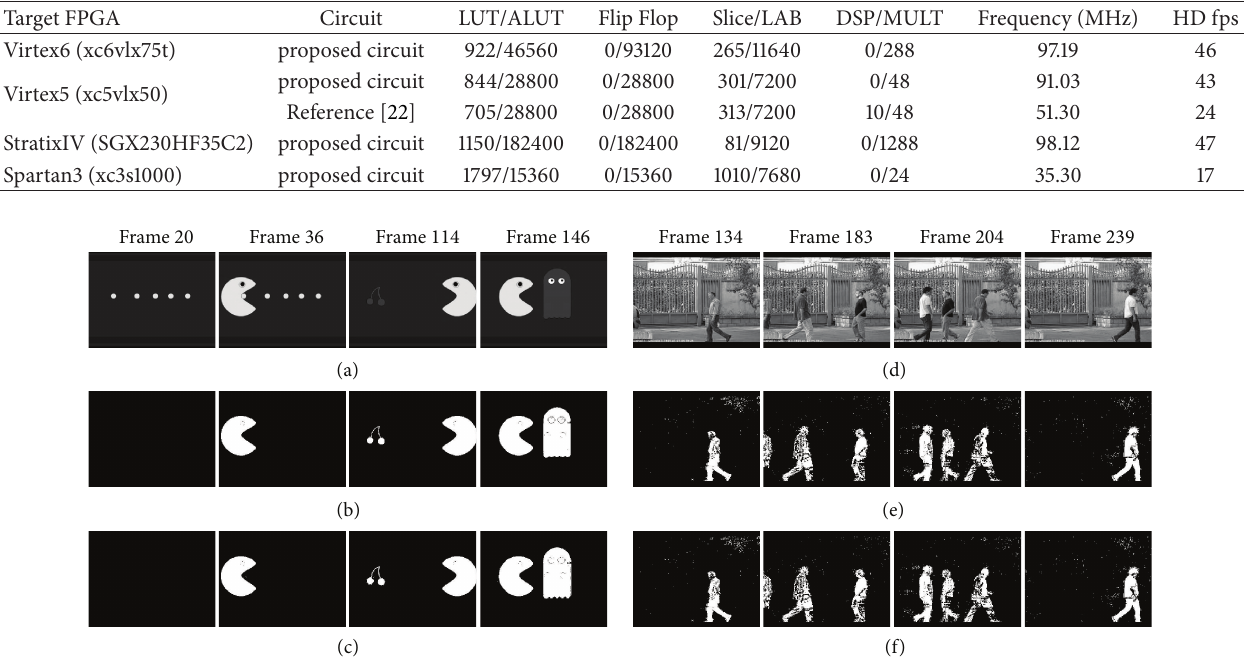
Figure 4: Comparison between the Bg masks obtained with the circuit of [22] and with the proposed implementation. (a), (d) unprocessed video frames; (b), (e) output of the proposed circuit; (c), (f) output of the circuit proposed in